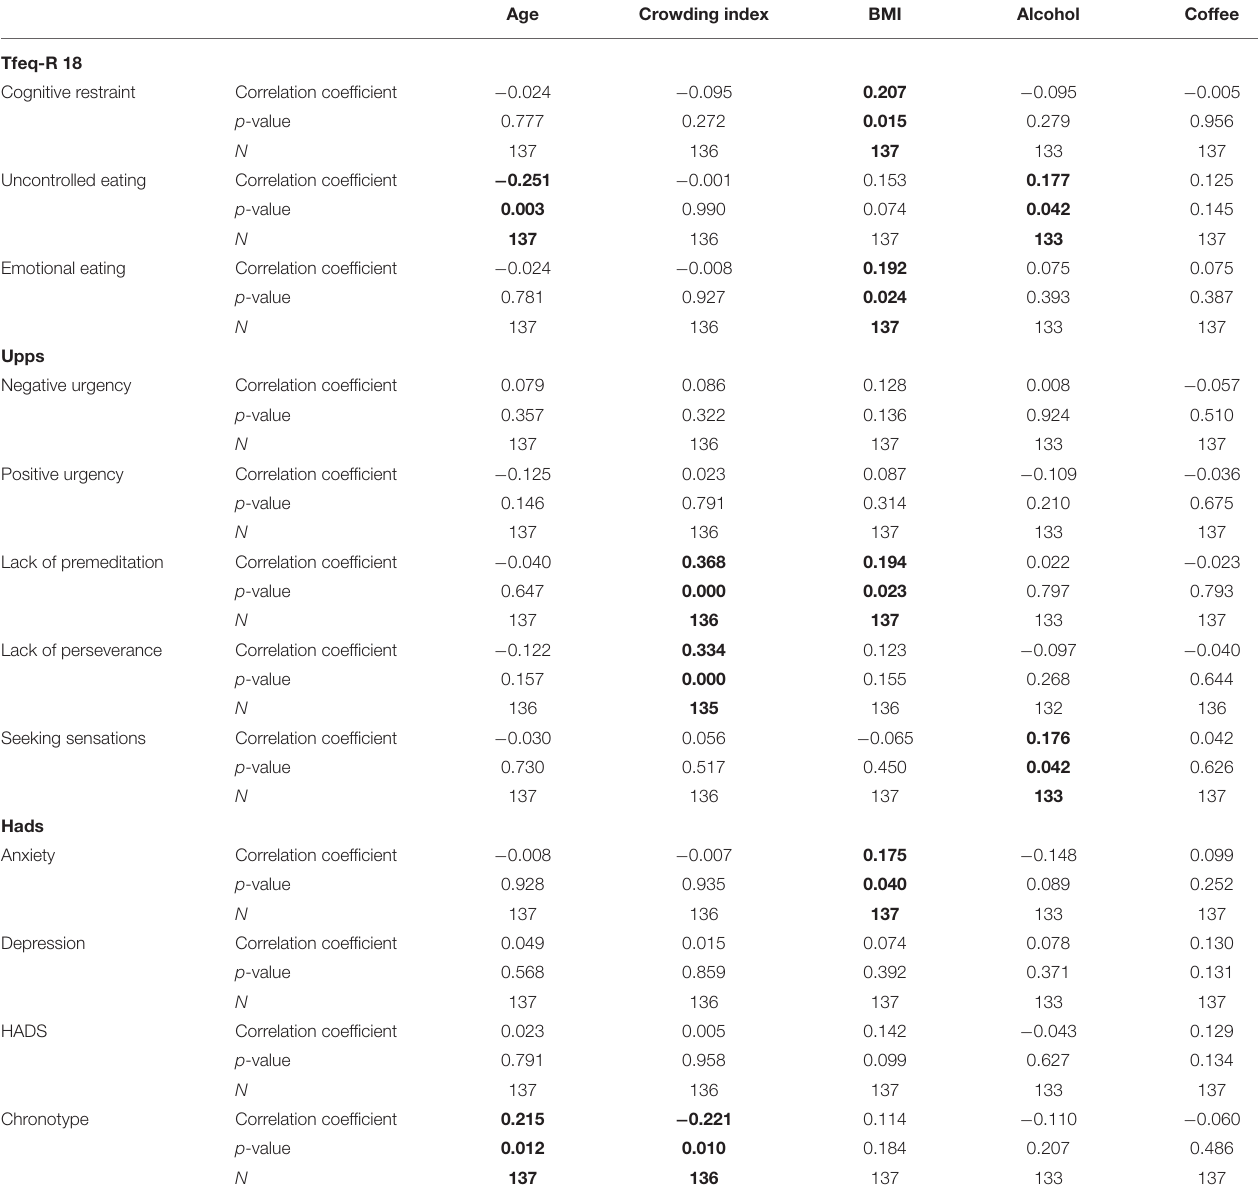
TABLE 3 | Associations between the different components of the questionnaires and the continuous socio-demographic characteristics of male participants ( N =